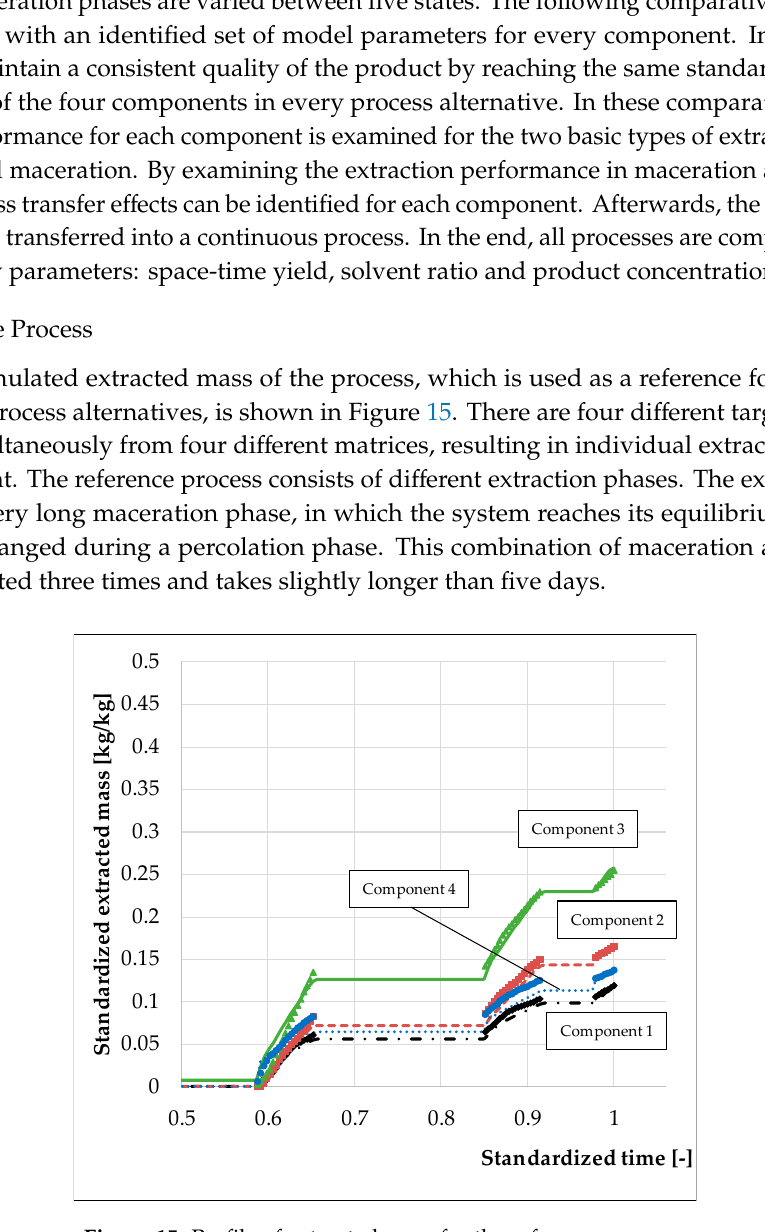
Figure 15. Profile of extracted mass for the reference process.